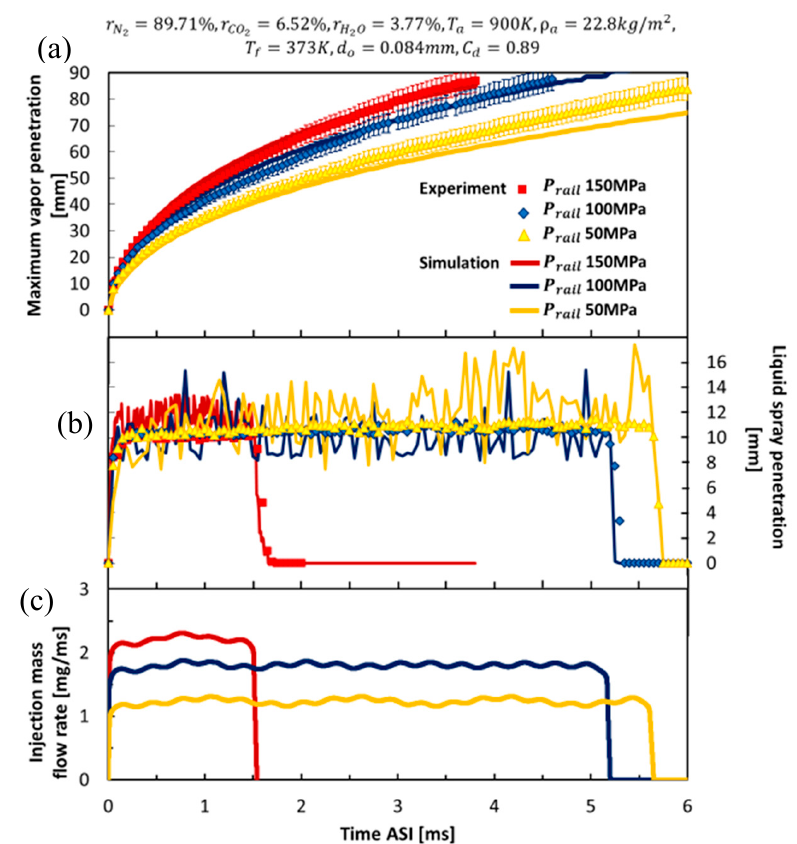
Figure 9. Comparison of the spray penetration of the experiment results [23] and the simulation results for different rail pressures. ( a ) Maximum vapor penetration, ( b ) liquid spray penetration and ( c ) injection mass flow rate.